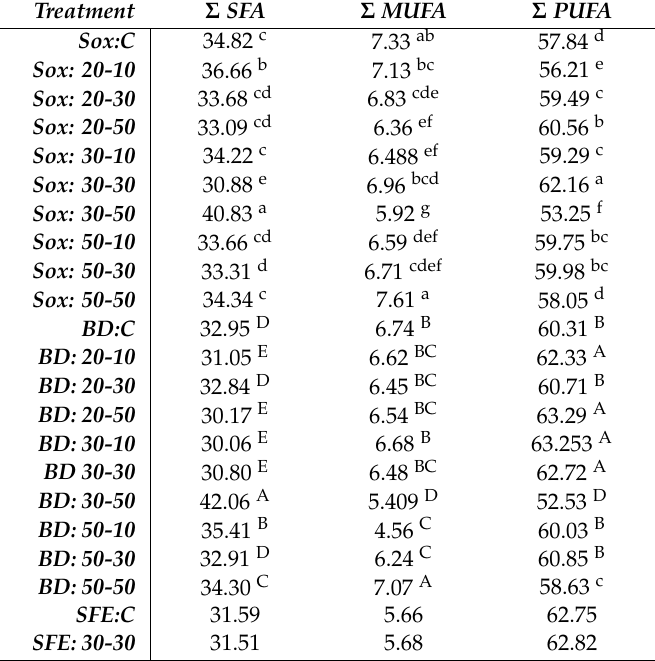
Table 2. Sum of fatty acid profile (%) of grape seed oil samples using di ff erent treatment conditions (ultrasound) by low pressure methods (Sox and BD), the best extraction condition for supercritical fluid (SFE) and their respective untreated controls